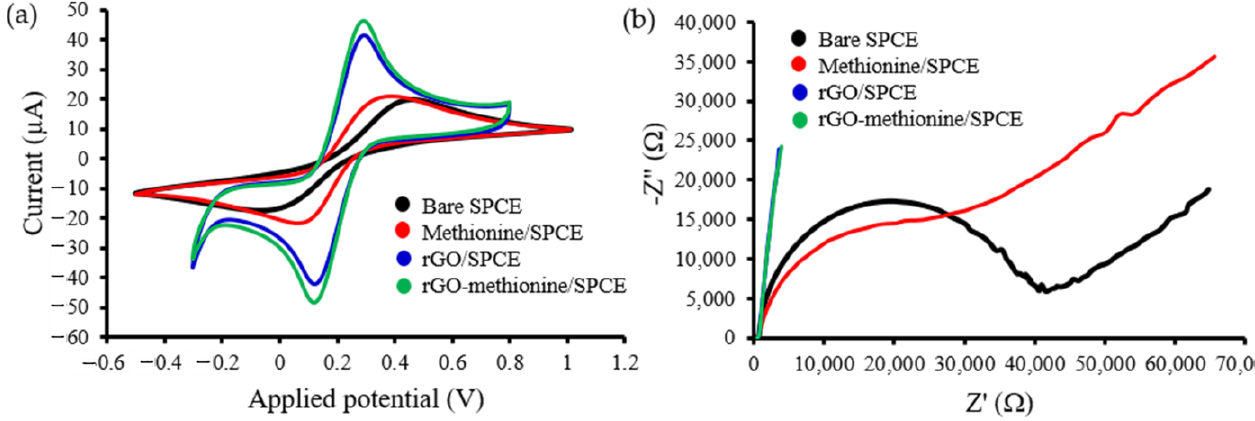
Figure 2. Electrochemical characterization of electrode modification by CV at scan rate 50 mV/s ( a ) and EIS ( b ).